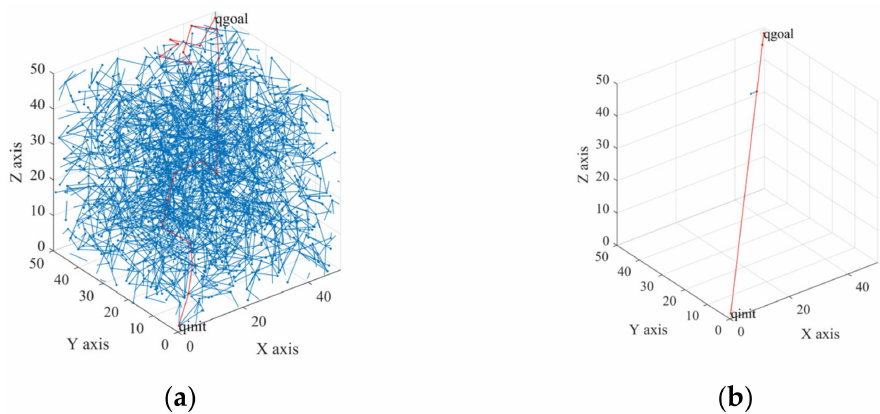
Figure 5. Fixed step size and attractive step size. ( a ) Fixed step size; ( b ) Attractive step size.